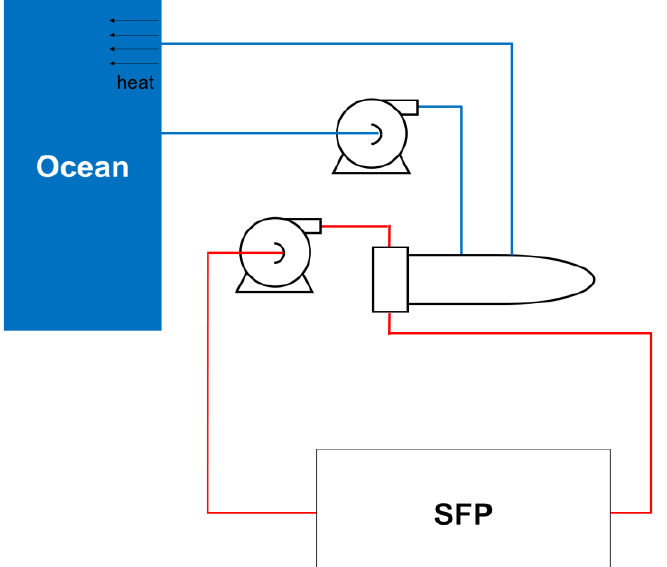
Figure 4. Schematic of ocean-cooled indirect heat exchange system.